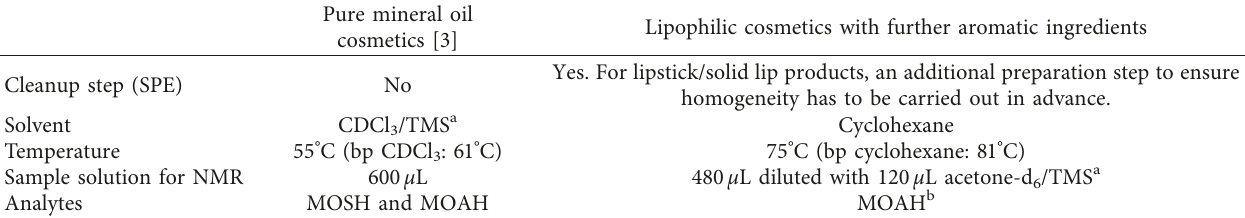
Table 3: qNMR-analysis of pure mineral oil cosmetics and lipophilic cosmetics with further aromatic ingredients.